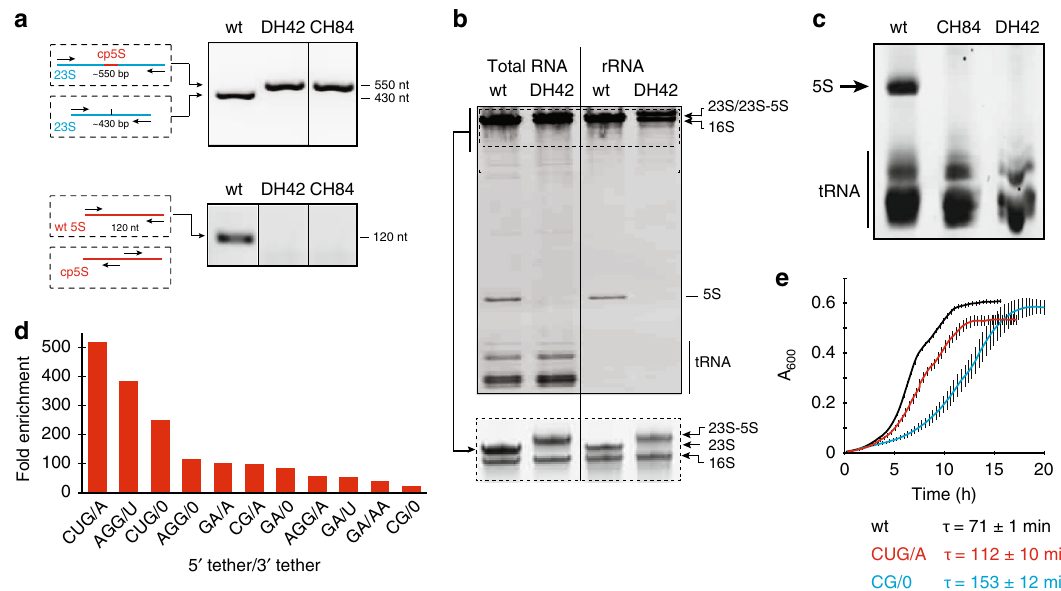
Fig. 3 The 23S-cp5S ribosomes support cell growth in the absence of free 5S rRNA. a PCR analysis of rDNA in the E. coli SQA18 cells expressing wt 23S rRNA or chimeric 23S-cp5S rRNAs. Top: PCR with 23S rRNA-speci fi c primers (black) fl anking the site of cp5S rRNA (red) insertion into 23S rRNA (blue). Bottom: PCR with 5S rRNA-speci fi c primers (black) annealing to the ends of wt 5S rRNA gene (red) generate no ampli fi ed product when DNA from the DH42 or CH84 clones is used as a template. b Polyacrylamide gel electrophoresis of total RNA or rRNA isolated from wt or SQA18/DH42 cells. Bottom: same samples as above but running electrophoresis for an extended time to improve separation of the large rRNA species. c Gel electrophoresis analysis of small RNA extracted from wt, SQA18/CH84, or SQA18/DH42 cells cured of the pCSacB plasmid. The gel was purposefully overloaded to con fi rm the lack of free 5S rRNA in the CH84 and DH42 clones. d Identi fi cation of the best linker combinations for the 23S-cp5S DH42 construct. The bar graph shows the fold enrichment of the indicated linker pairs in the selected library relative to the unselected one. e Growth of the E. coli SQA18 strain expressing wt ribosomes (black line) or ribosomes containing 23S-cp5S variants DH42(CUG/A) (referred as DH42*) (red line) and DH42(CG/0) (blue line). Each curve is an average of three replicates, with error bars indicating s.d. Calculated doubling time ( τ ) of the strains is indicated. The representative gels of at least two independent experiments are shown in a – c .